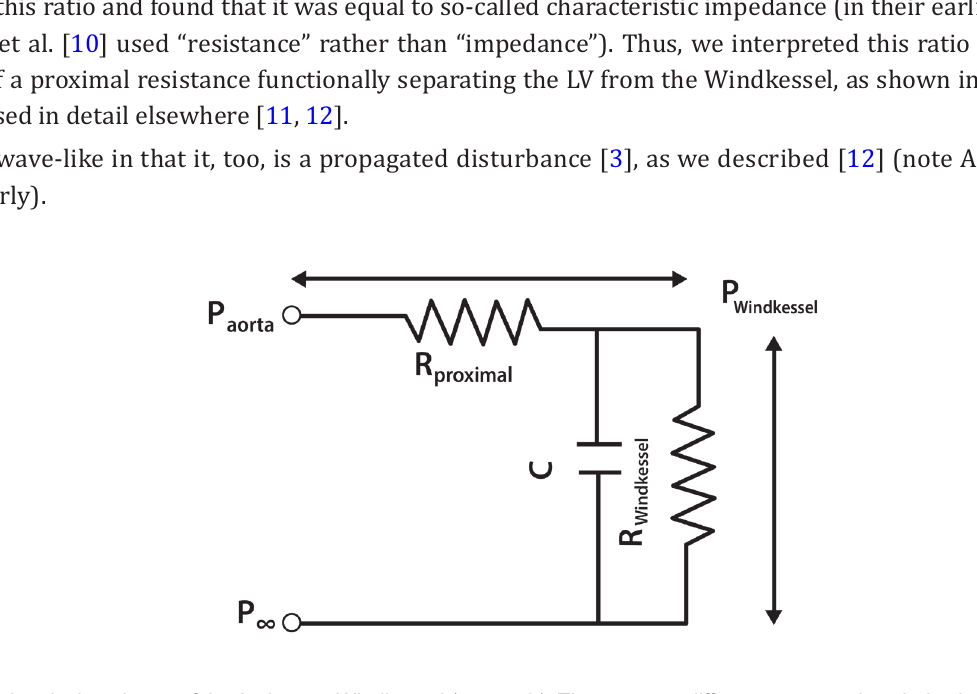
and P . R is a resistance interposed between the LV and the Windkessel and is equivalent aorta ∞ proximal is generated by the passage of Q through R and is equal to the pressure difference wave in proximal is the resistance of the reservoir (filter). The pressure difference specifically due to the Windkessel – P ) [11] Windkesse ∞